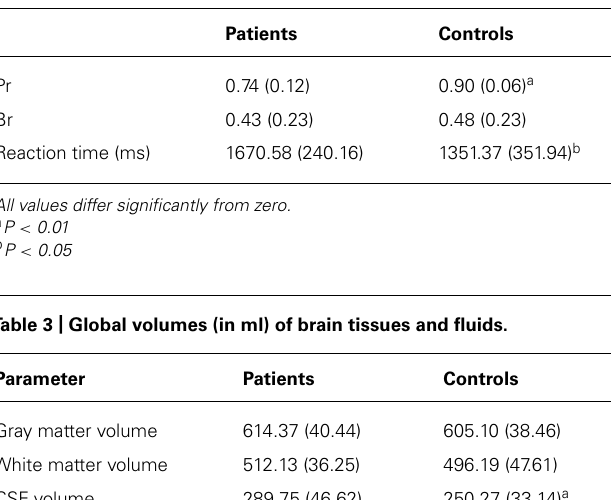
Table 2 | Mean performance (Pr) and response bias (Br) scores and reaction times of patient and control group in the recognition memory task (SD in parentheses).